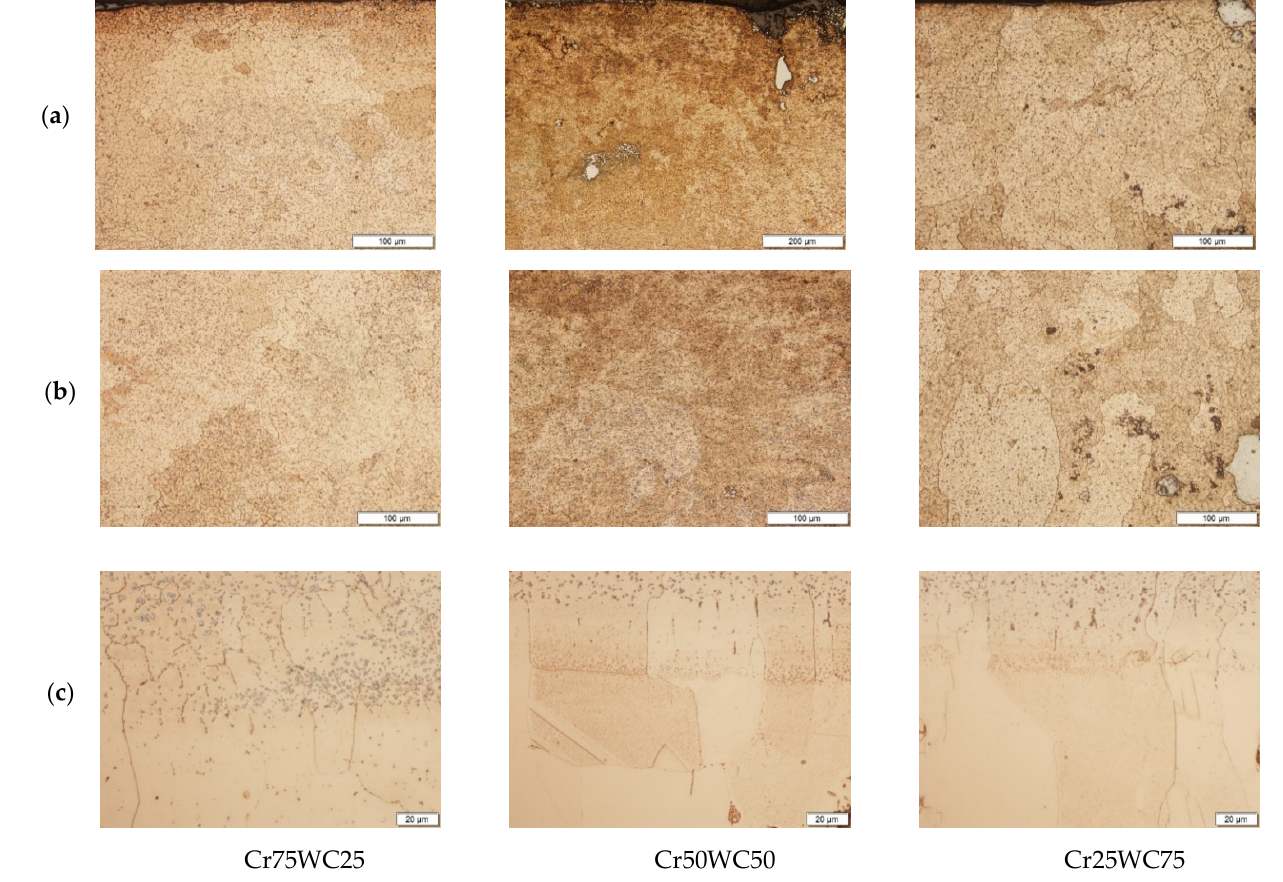
Figure 4. Cross-sectional images of LSA-treated samples with different percentage contents of Cr–WC, ( a ) upper area of the alloyed zone, ( b ) middle of the area zone, ( c ) boundary between surface layer and substrate.